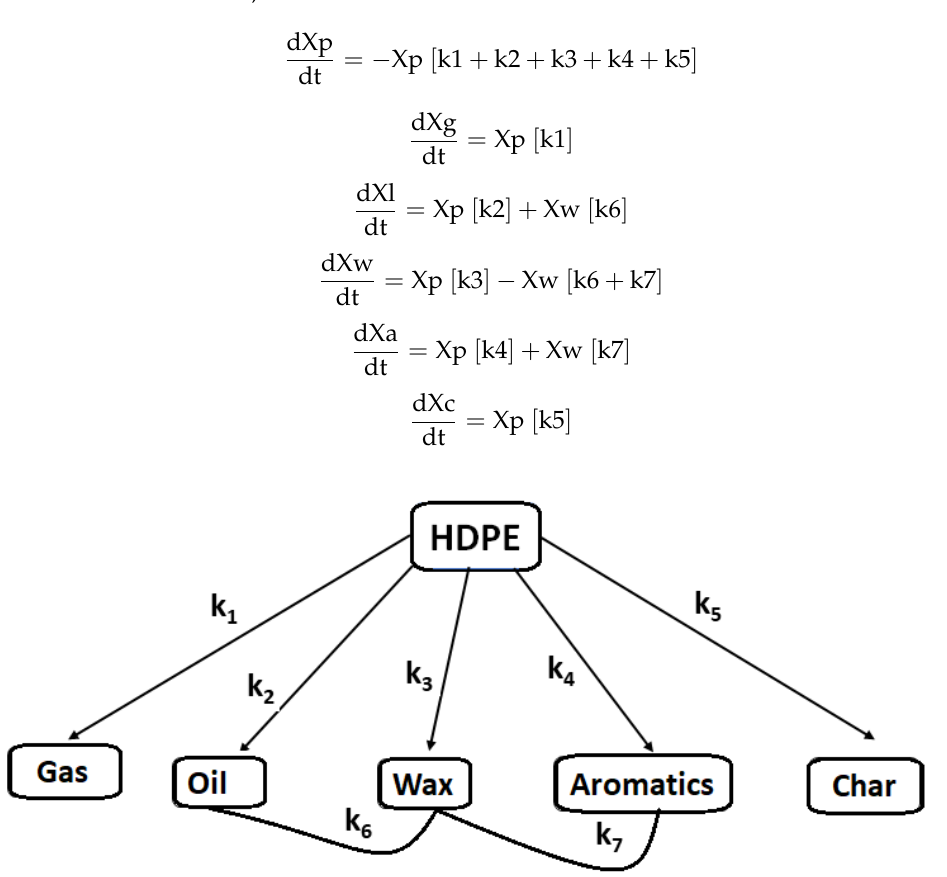
Figure 5. Depiction of the analytical model process based on the reaction rate constants.